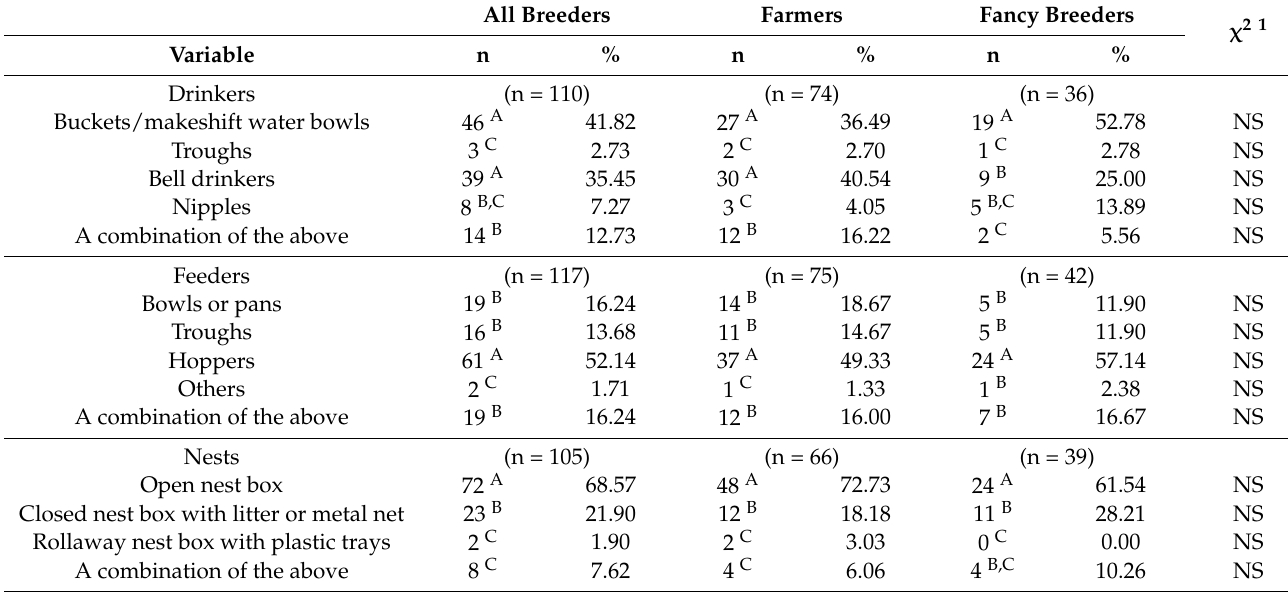
Table 9. Shed types and pen furnishings: responses from all breeders and divided according to breeder category.